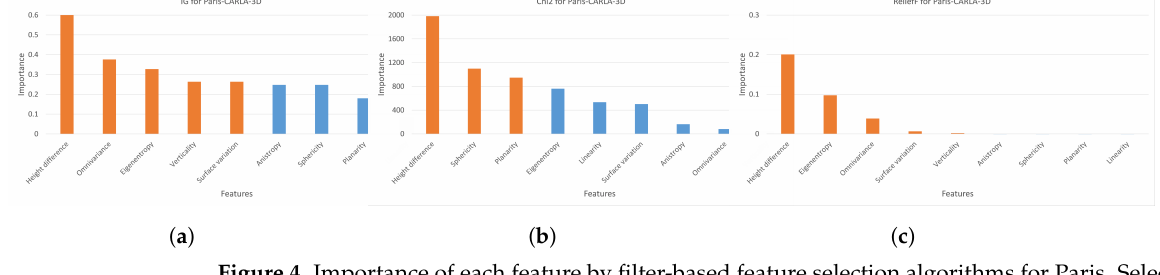
Figure 4. Importance of each feature by filter-based feature selection algorithms for Paris. Selected features are marked as orange. ( a ) Feature importance calculated with IG ( b ) Feature importance calculated with Chi2. ( c ) Feature importance calculated with